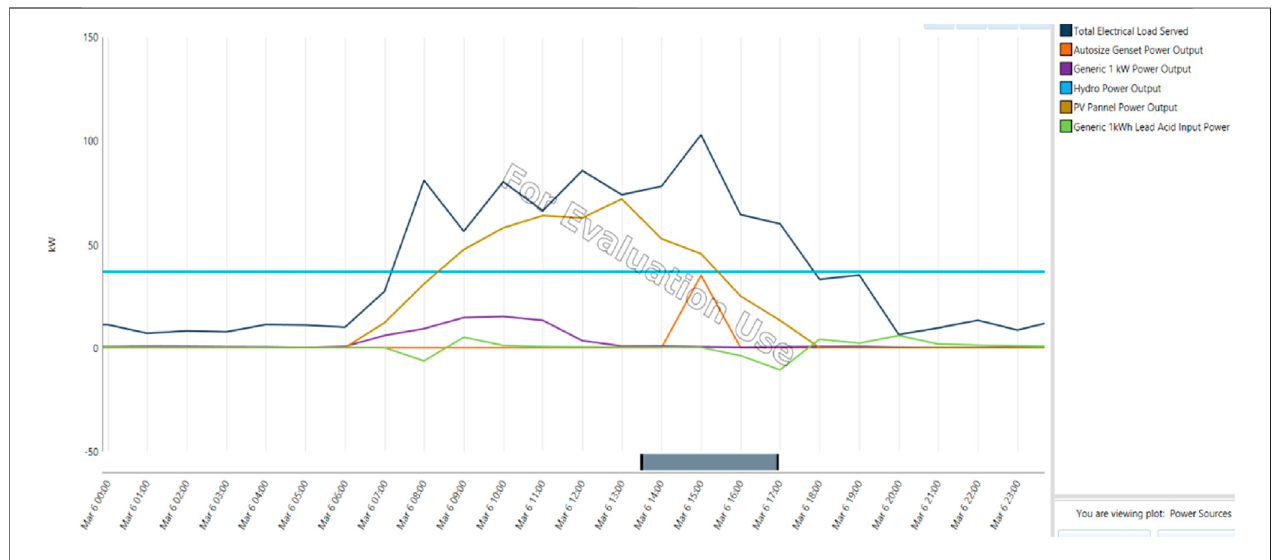
FIGURE 7 | On-line energy scheduling for March 6.